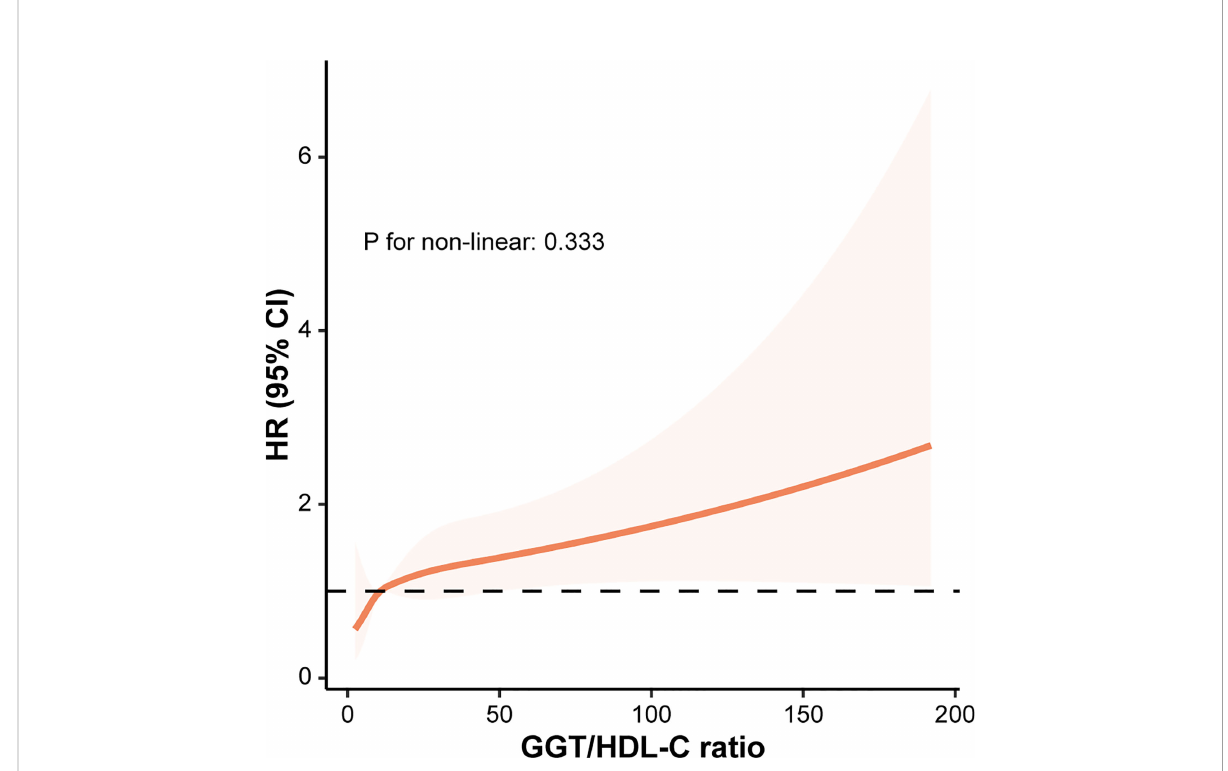
FIGURE 3 The correlation between GGT/HDL-C ratio and the risk of T2DM evaluated by restricted cubic splines. CI, con fi dence interval; GGT, gamma- glutamyl transferase; HDL-C, high-density lipoprotein cholesterol; HR, hazard ratio; T2DM, type 2 diabetes mellitus.